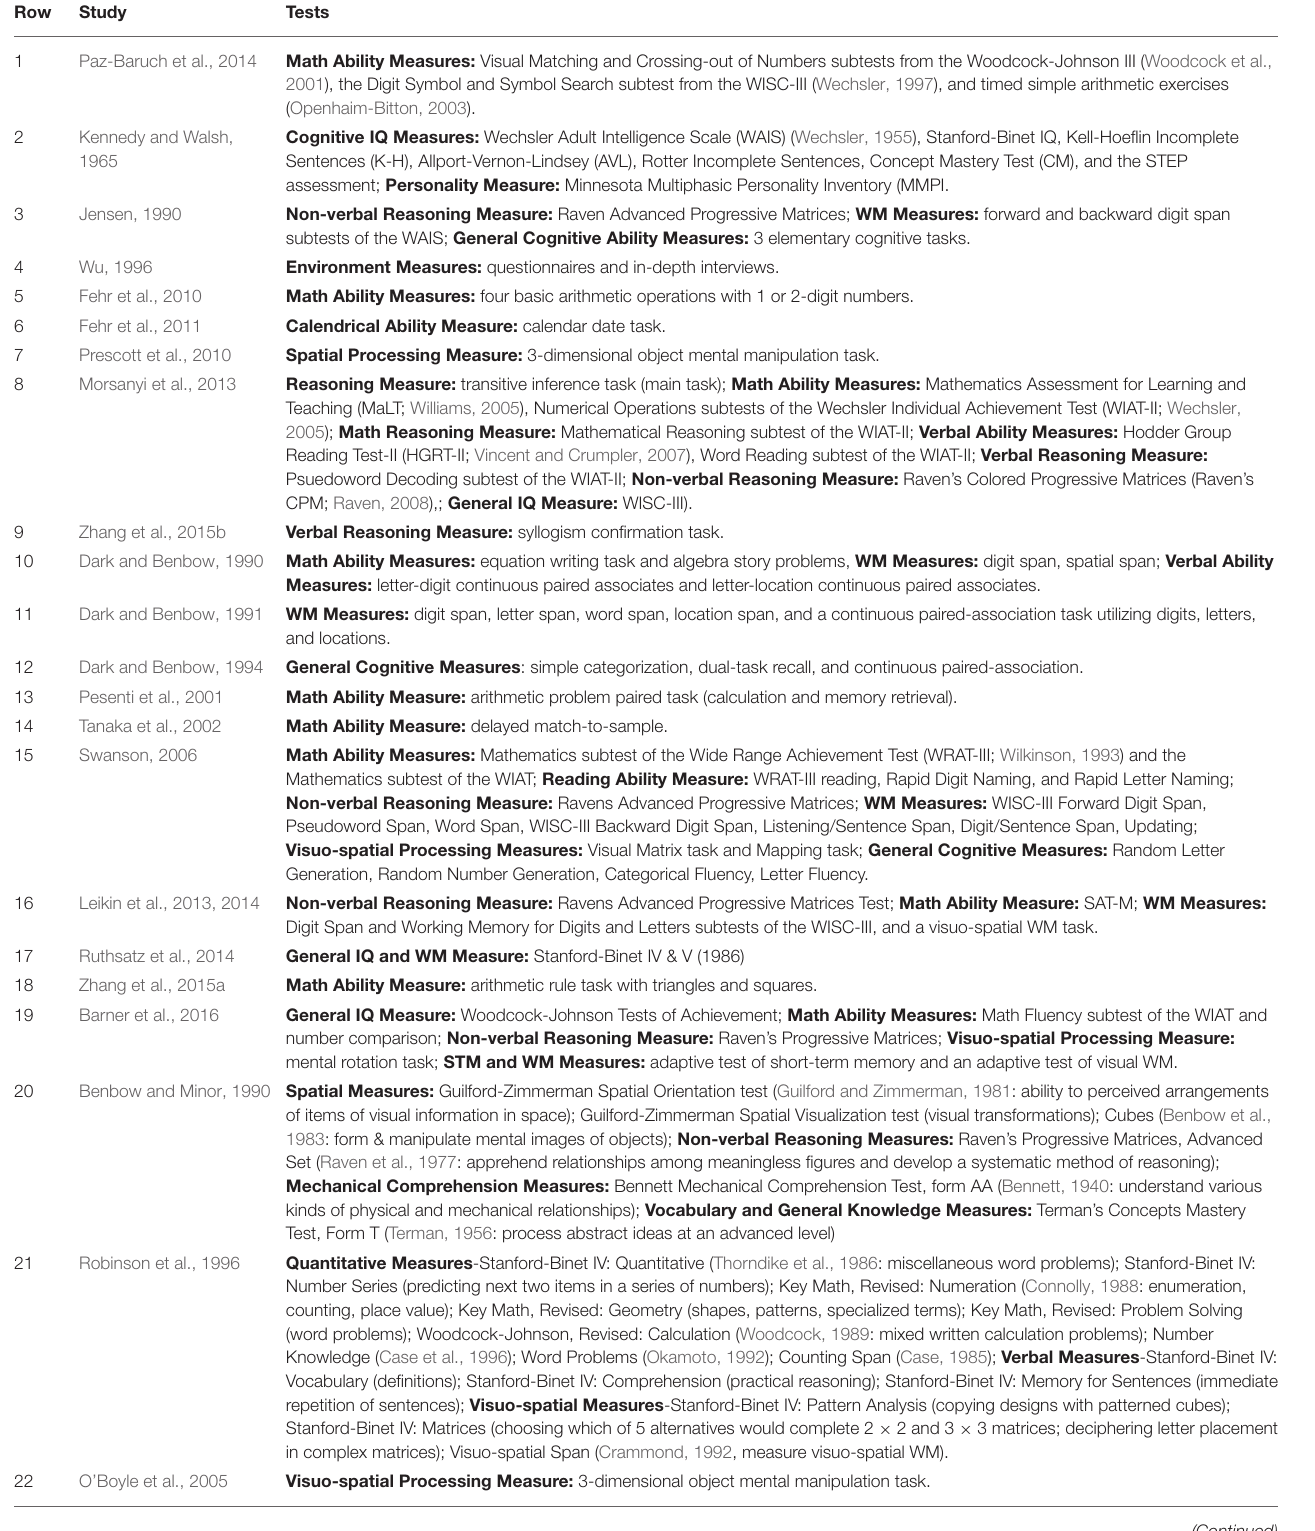
TABLE 1 | Standardized tests and other measures used across